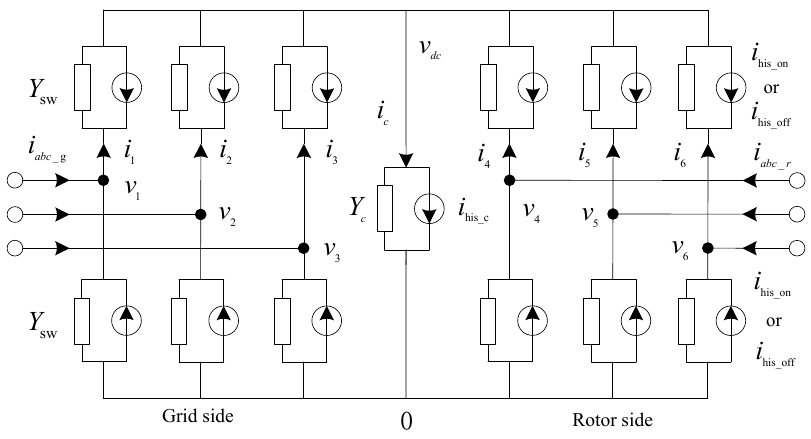
Figure 9. GST modeling of back-to-back converters.